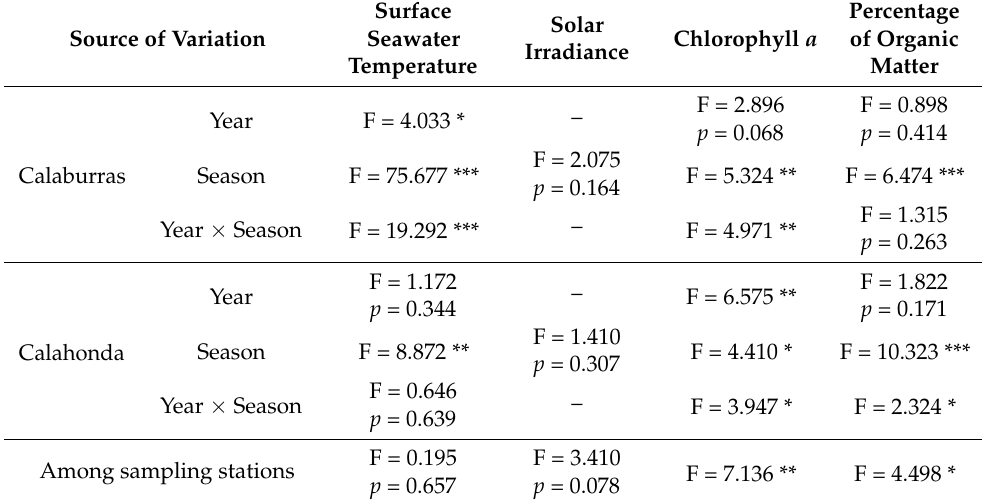
Table 2. Results of one and two-way PERMANOVA test for spatial and temporal changes of envi- ronmental variables in Posidonia oceanica meadows at Calaburras and Calahonda (Calahonda SAC, northwestern Alboran Sea) in relation to sampling stations, months from different seasons and years (annual cycles). Significant differences are indicated by: * p < 0.05; ** p < 0.01; *** p < 0.001. Surface Percentage Solar Source of Variation Seawater Chlorophyll a of Organic Irradiance Temperature Matter F = 2.896 F = 0.898 Year F = 4.033 * – p = 0.068 p = 0.414 F = 2.075 Season F = 75.677 *** F = 5.324 ** F = 6.474 *** Calaburras p = 0.164 F = 1.315 Year × Season F = 19.292 *** – F = 4.971 ** p = 0.263 F = 1.172 F = 1.822 – F = 6.575 ** Year p = 0.344 p = 0.171 F = 1.410 Season F = 8.872 ** F = 4.410 * F = 10.323 *** Calahonda p = 0.307 F = 0.646 – F = 3.947 * F = 2.324 * Year × Season p = 0.639 F = 0.195 F = 3.410 Among sampling stations F = 7.136 ** F = 4.498 * p = 0.657 p =